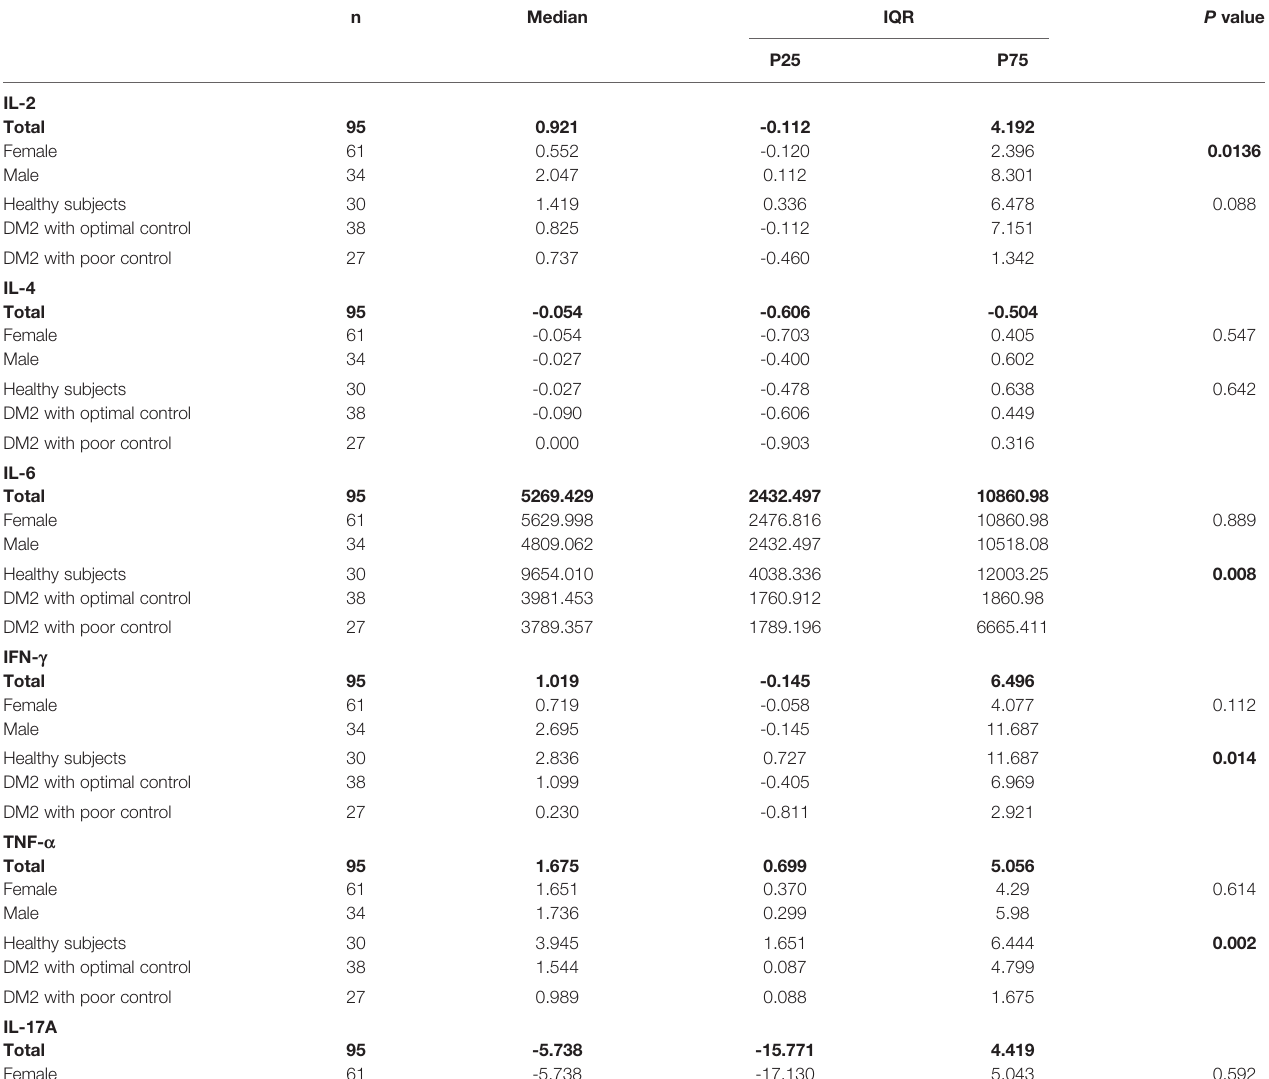
TABLE 2 | Comparison of cytokine production (pg/mL) between studied groups.